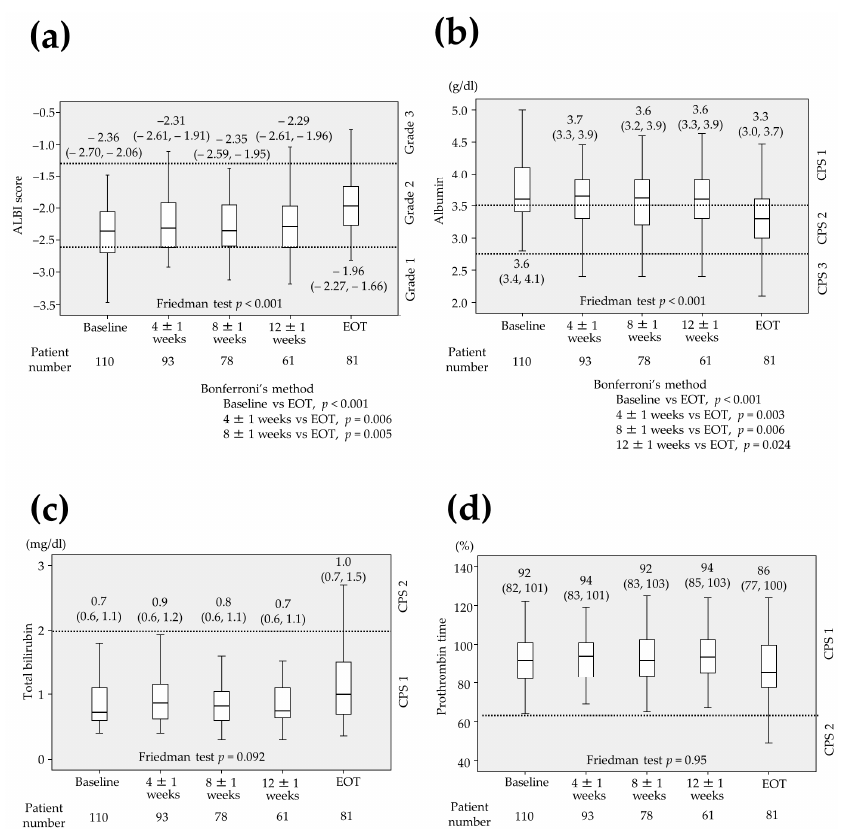
Figure 2. Changes in parameters associated with liver function. ( a ) albumin-bilirubin (ALBI) score ( b ) serum albumin ( c ) total bilirubin ( d ) prothrombin time. ( a , b ) The ALBI score and the serum albumin